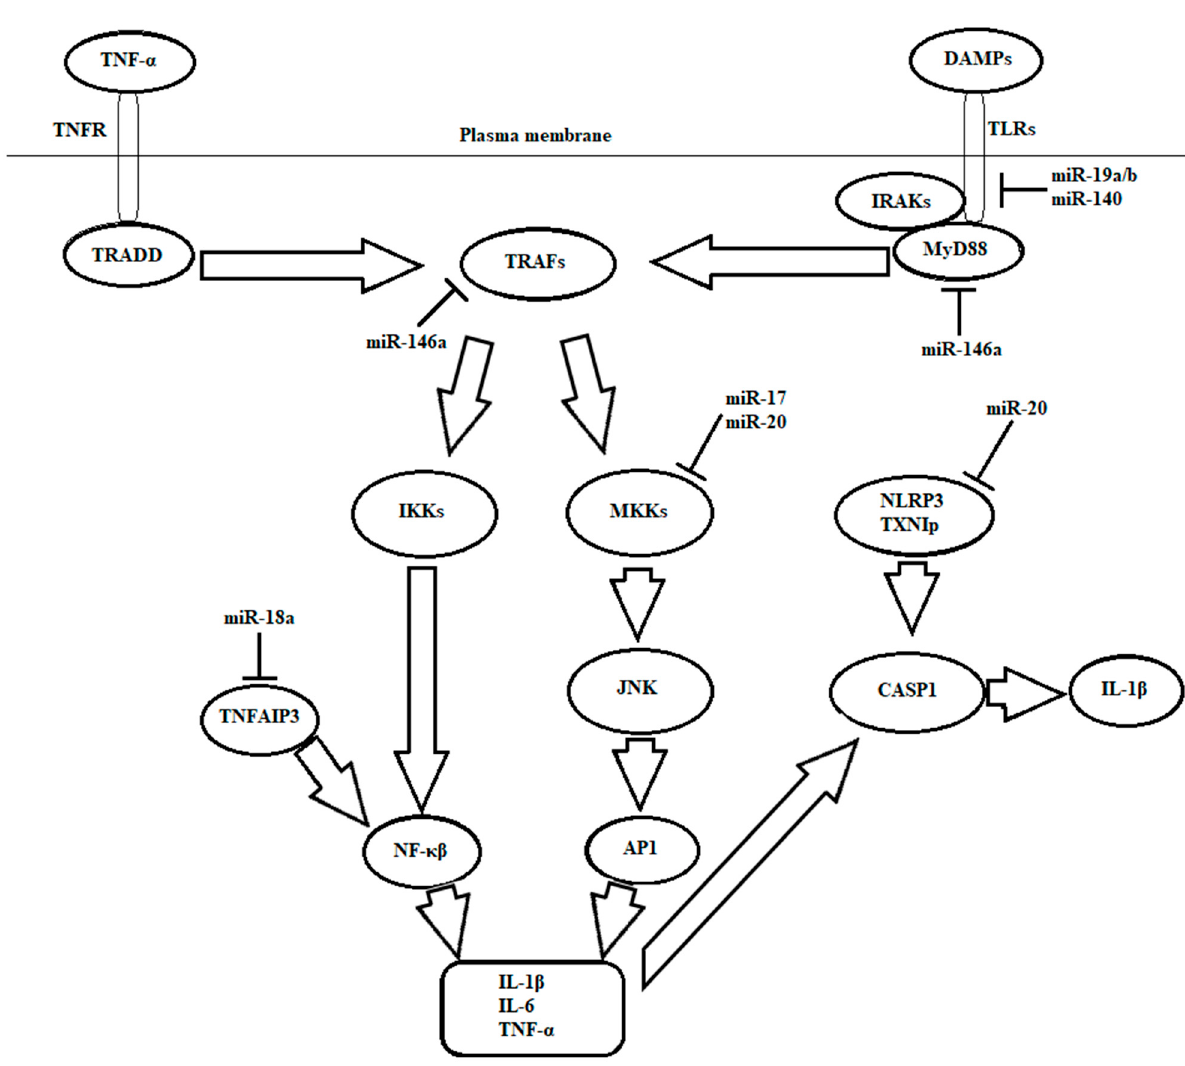
Figure 2. TNF (tumor necrosis factor) and TLR (Toll-like receptor) signaling pathways with the miRNAs that target them.